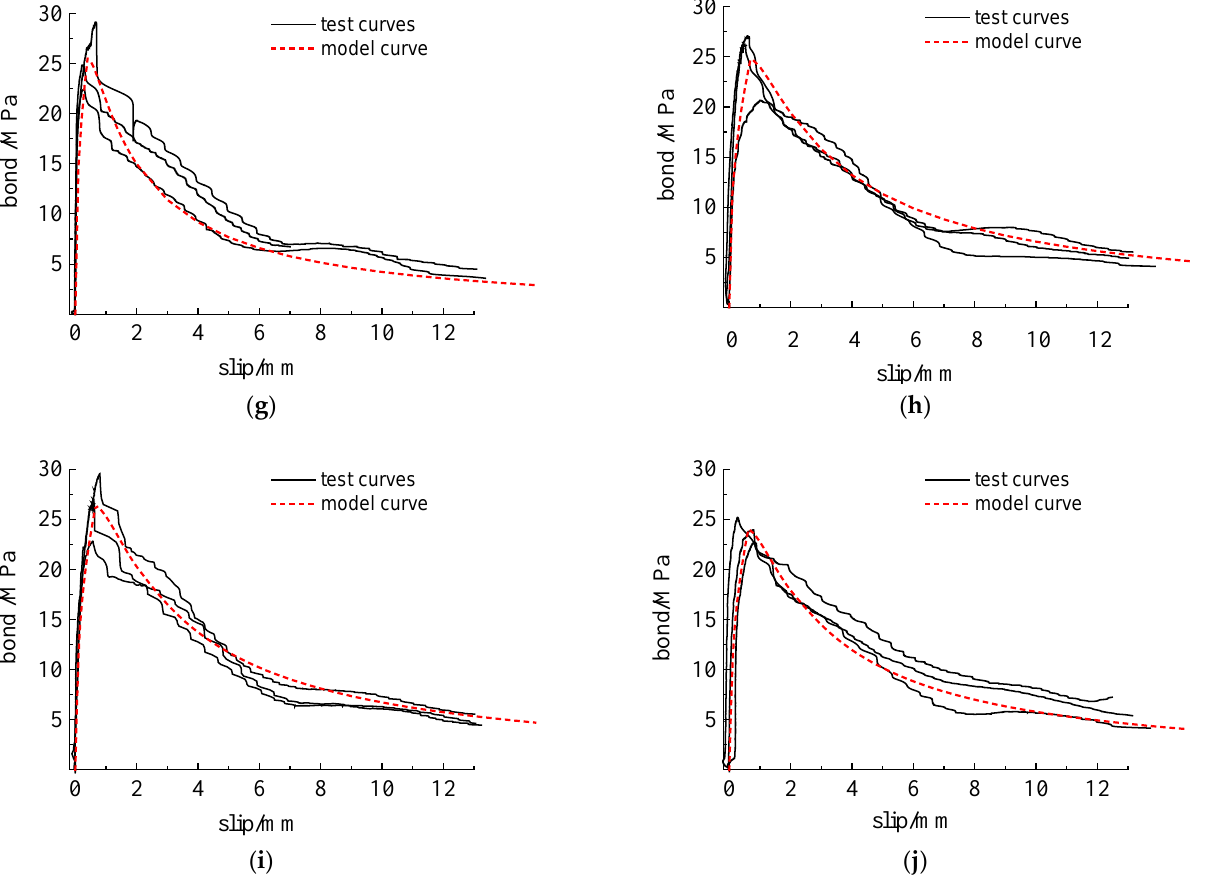
Figure 11. Bond–slip relationship curves ofC20 and C40 specimens with ribbed steel bars. ( a ) C20F0; ( b ) C20F25; ( c ) C20F50; ( d ) C20F75; ( e ) C20F100; ( f ) C40F0; ( g ) C40F25; ( h ) C40F50; ( i ) C40F75; ( j ) C40F100.